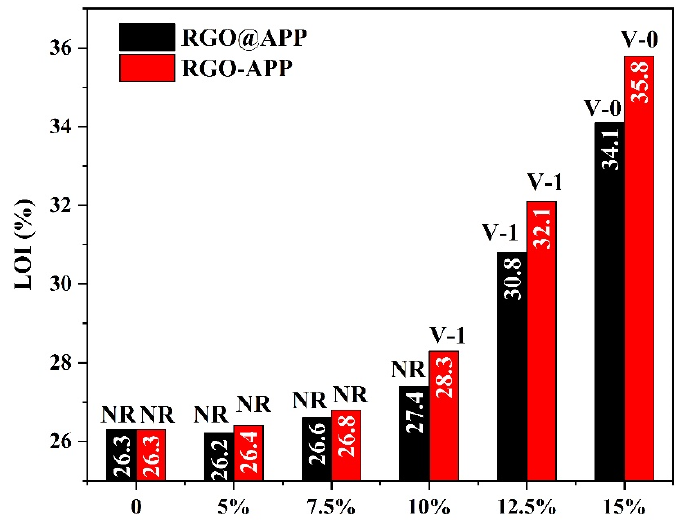
Figure 7. LOI values and UL94 ratings of flame-retardant EP.